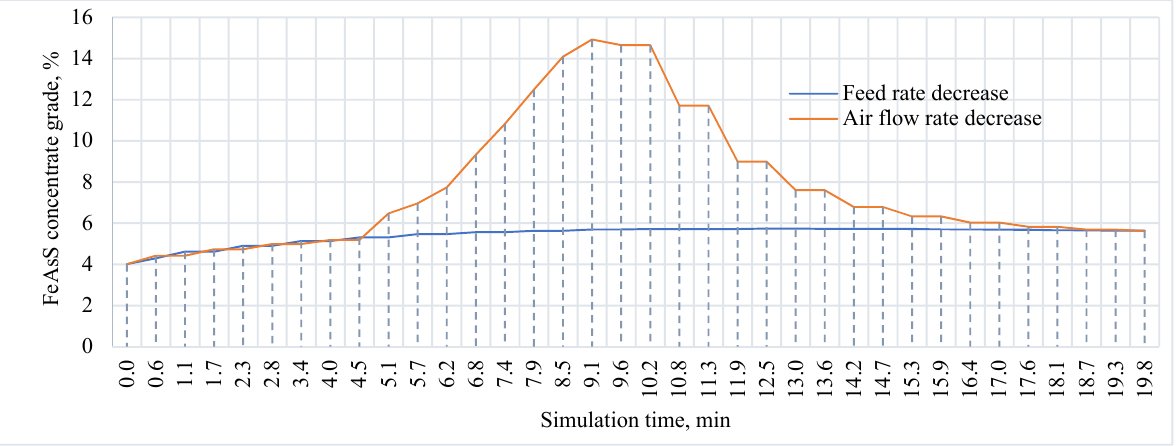
Figure 16. FeAsS concentrate grade values in the simulation.